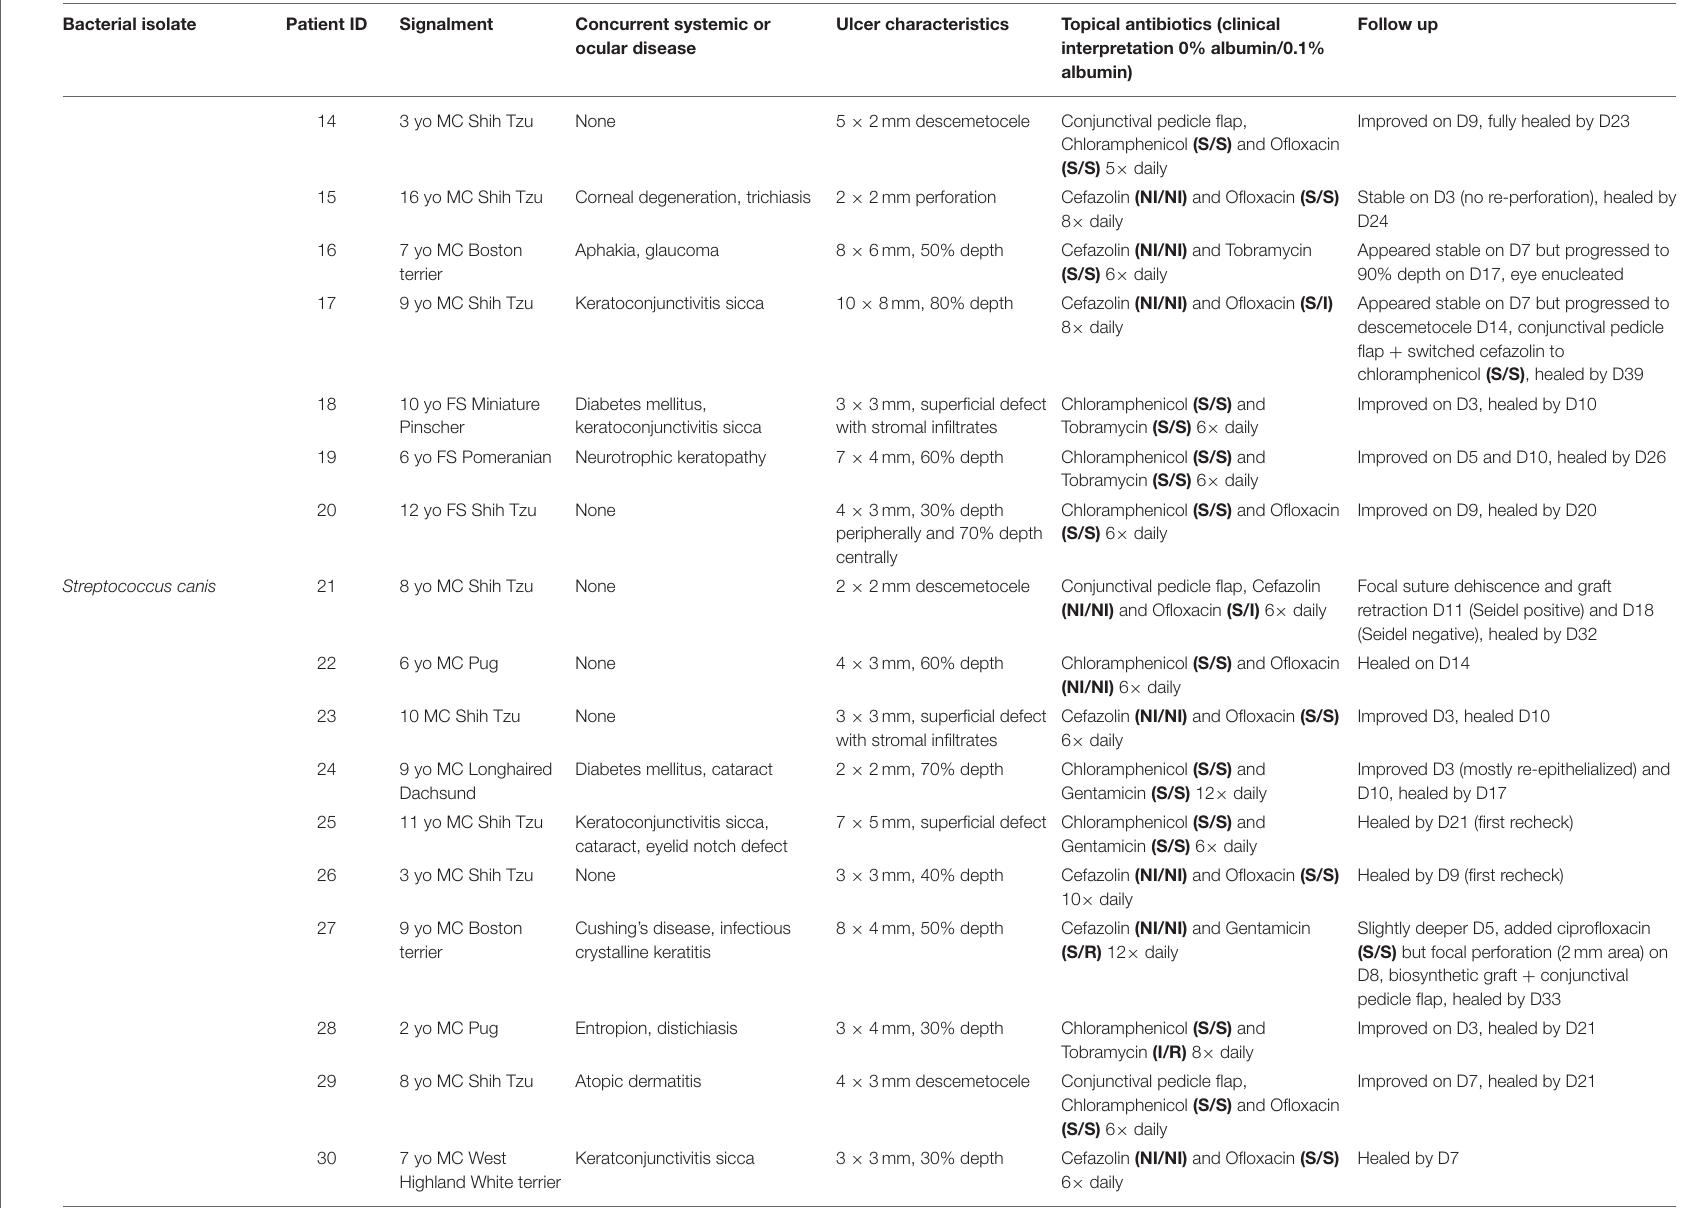
Bolded letters represent the clinical interpretations received by the clinician (letter before slash, issued from MIC testing with standard test medium) and the one extrapolated from MIC results for test medium supplemented with 0.1% albumin (letter after slash). S, Susceptible; I, Intermediate; R, Resistant; NI,